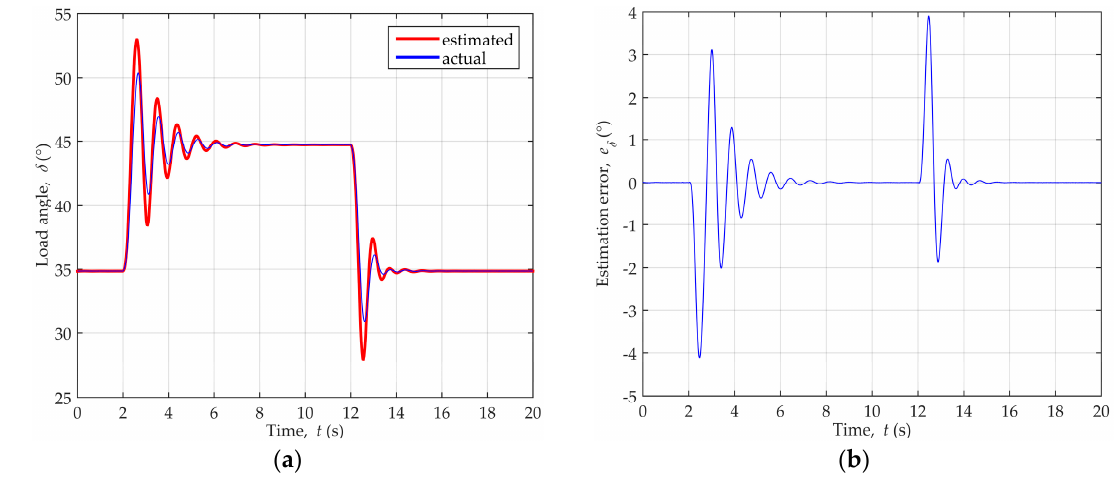
Figure 12. Load angle variation during dynamic disturbances of reactive power for generator operating point P = 0.89, Q = 0.11 cap.: ( a ) Comparison of the actual and estimated load angle values; ( b ) Load angle estimation error.